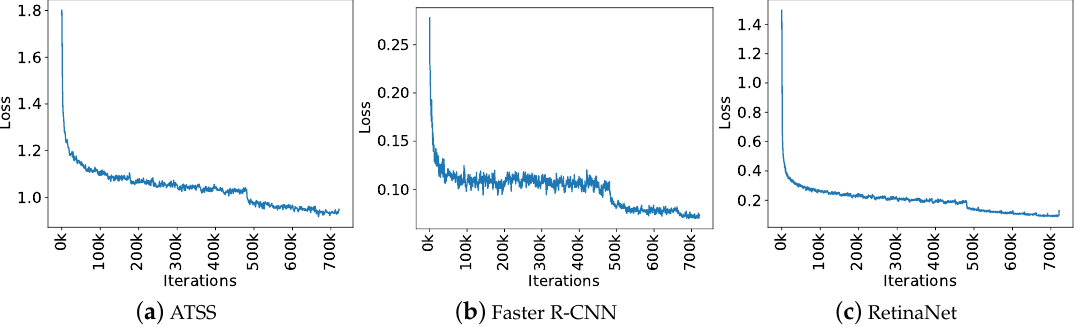
Figure 4. Loss function during training for the three object detection